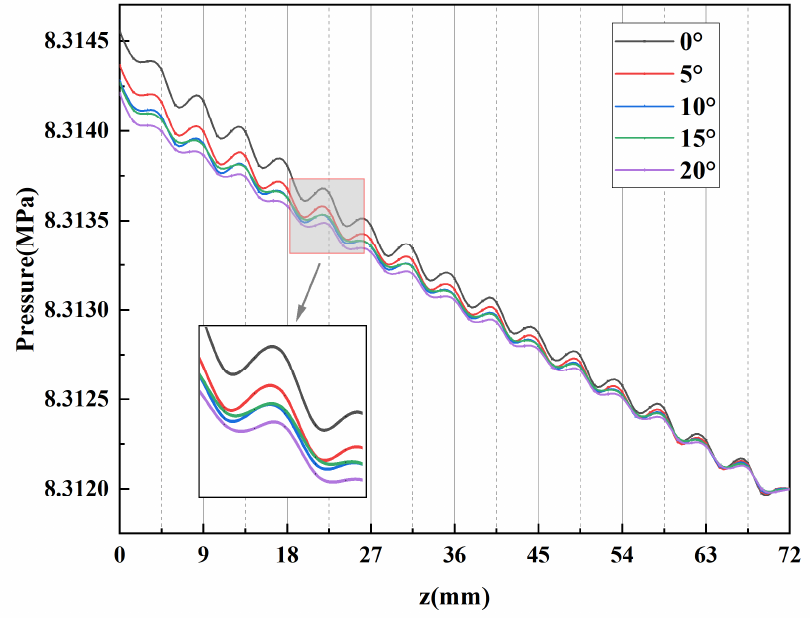
Figure 10. Relationship between the cold side pressure drop and angle θ of spiral